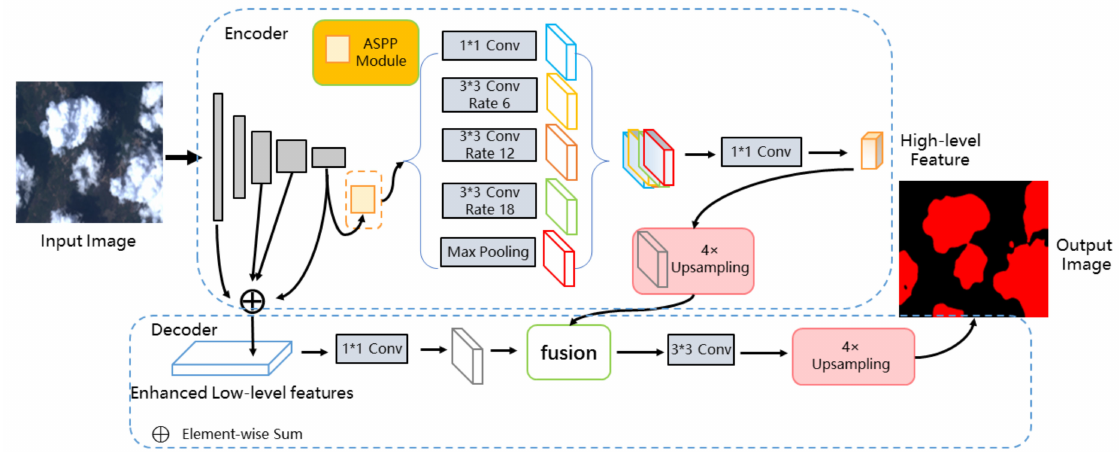
Figure 5. Network architecture of the proposed